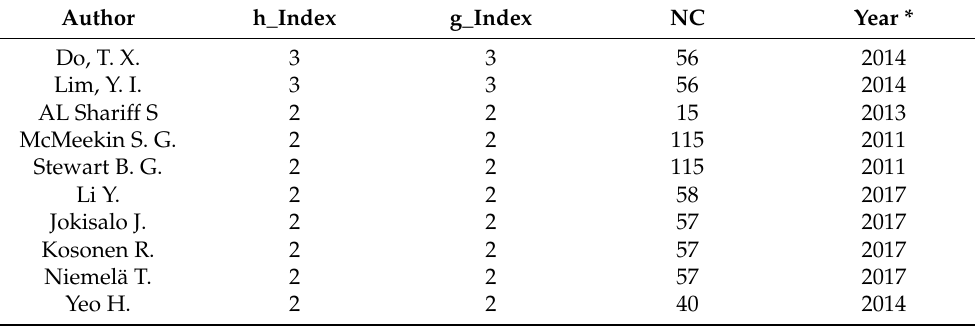
Table 9. Authors Impact (ROI).